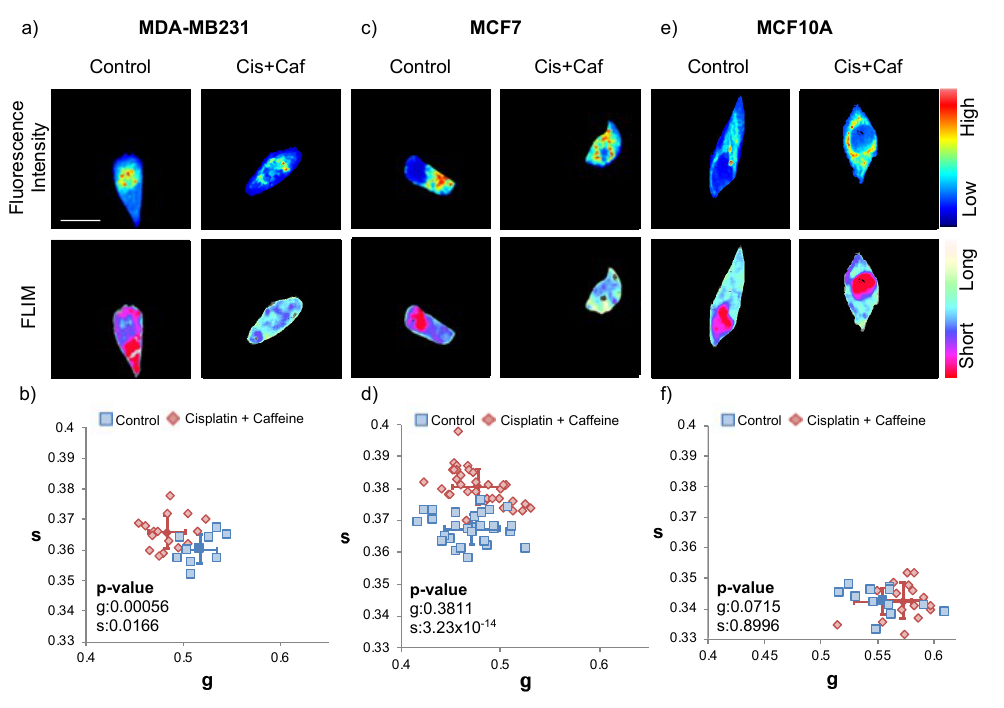
Figure 4. Fluorescence lifetime trajectories of the metabolic state of MDA-MB-231, MCF7 and MCF10A cells with ca ff eine and cisplatin treatment. ( a ) Fluorescence intensity image (top), and FLIM image pseudo colored long lifetime as cyan and short lifetime as red (bottom) for control and ca ff eine and cisplatin-treated MDA-MB-231 cells; the scale bar is 20 µ m and all the images in this figure have the same scale. Note a shift in long to short lifetime correlates to blue to red in the FLIM images. ( b ) The g and s values of control and cisplatin and ca ff eine treated MDA-MB-231. The blue squares are from the controls (untreated MDA-MB-231), red diamonds are from the cisplatin and ca ff eine treated MDA-MB-231, and the solid shapes (square and diamond) with the error bars correspond to the average and standard deviation of each group (Student t-test p -value compare the treated group to the control group: g = 0.00056, s = 0.0166, free to bound NADH ratio = 3.63 × 10 − 5 ). FLIM plot illustrates a leftward shift from short to long lifetimes. ( c ) Fluorescence intensity image (top), and FLIM image pseudo colored long lifetime as cyan and short lifetime as red (bottom) for control and ca ff eine and cisplatin-treated MCF7 cells. ( d ) The g and s values of control and cisplatin and ca ff eine treated